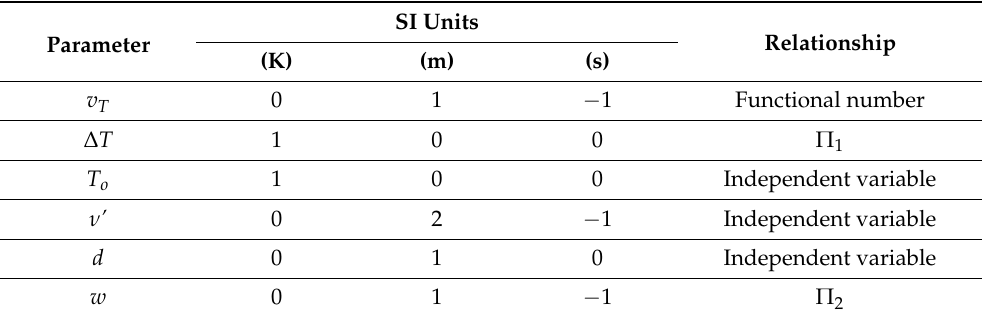
Table A2. Dimensional relationships between parameters explaining the velocity of temperature- change signal, v T.